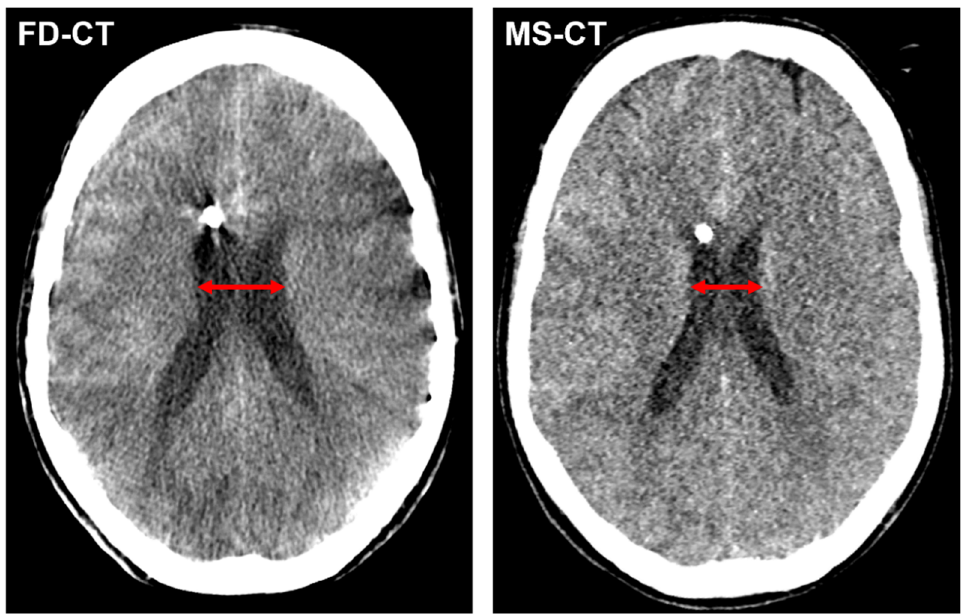
Figure 4. Exemplary cella media distance (CMD) measurement (red arrow) in a FD-CT and MS-CT dataset of a patient with endovascular treated, aneurysmal SAH and slightly declining width of the lateral ventricles from postinterventional FD-CT to MS-CT.